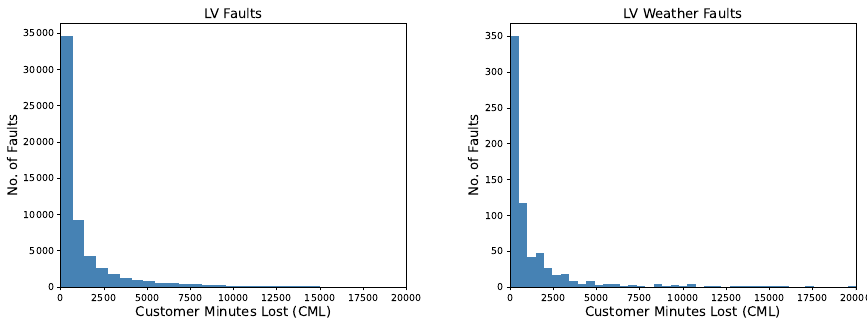
Figure 5. Distribution of the CML that resulted from the LV faults in NPG distribution network licence area ( left : all faults, right : weather related